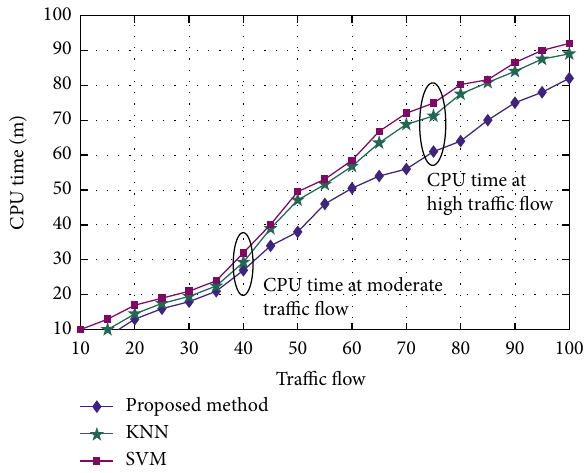
Figure 14: CPU comparison of the proposed method with other